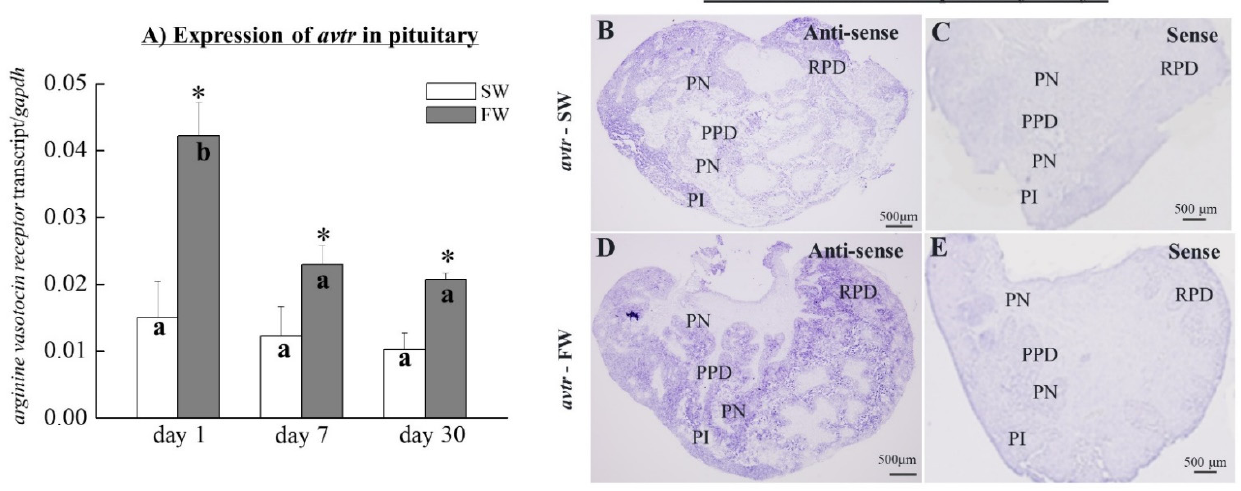
Figure 5. ( A ) Q-PCR analyzed the transcripts of avtr in the pituitaries of SW and FW black porgies on day 1, day 7, and day 30 ( n = 8 in each group). Gene expression was normalized to the control ( gapdh ) gene. The results are expressed as mean ± SEM. Different letters indicate a significant difference between sampling points with the same treatment; asterisks (*) show differences between groups at the same time point; (two-way ANOVA followed by Tukey’s test, p < 0.05). ( B – E ) In situ hybridization of avtr in black porgy pituitary ( n = 4). The avtr transcripts were detected in the RPD of the FW ( D ) pituitary compared to the SW fish ( B ). There were no signals detected in the SW and FW fish when using the respective control sense probes of avtr on day 1 ( C , E ). RPD: rostral pars distalis; PPD: proximal pars distalis; PI: pars intermedia; and PN: pars nervosa.